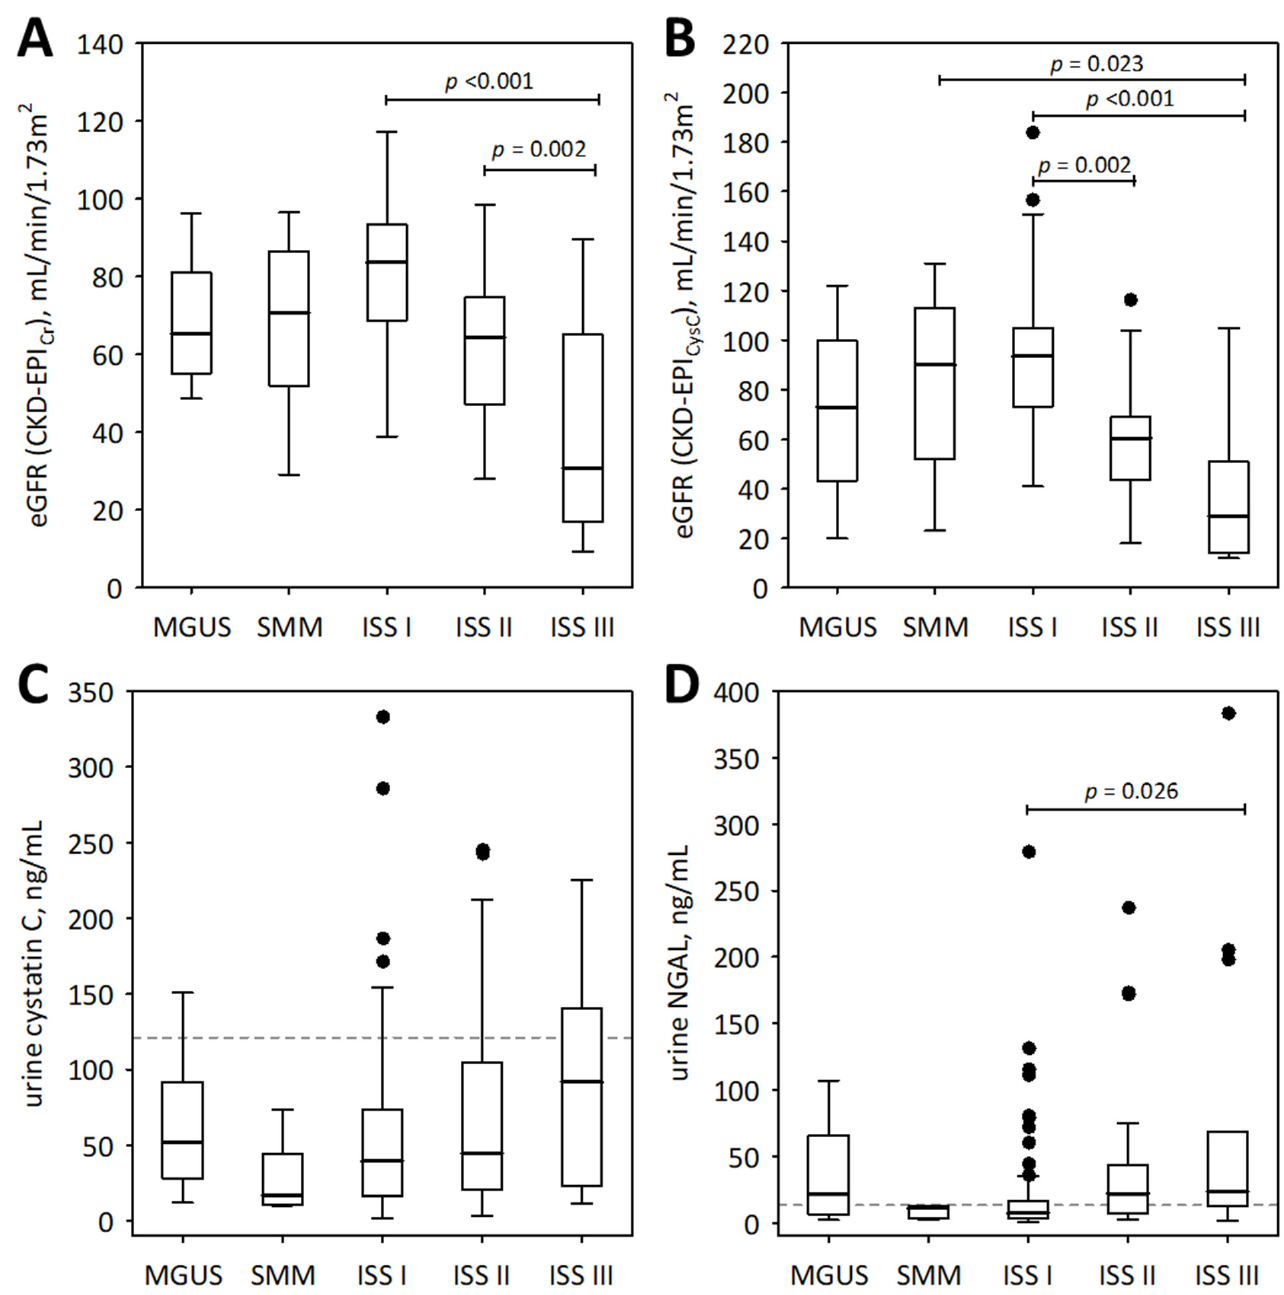
Figure 1. The values of eGFR based on serum creatinine ( A ) and cystatin C ( B ), and urinary concentrations of cystatin C ( C ) and NGAL monomer ( D ) among patients with monoclonal gammopathy ranging from MGUS to symptomatic MM. Data are shown as the median (central line), interquartile range (box), and non-outlier range (whiskers). The outliers are shown as points. We report p -values for significant differences between groups (calculated in post-hoc tests following the Friedman ANOVA). The dotted lines in panels ( C , D ) indicate non-outlier maximum urinary concentrations of the markers obtained in the control group of 21 healthy individuals.